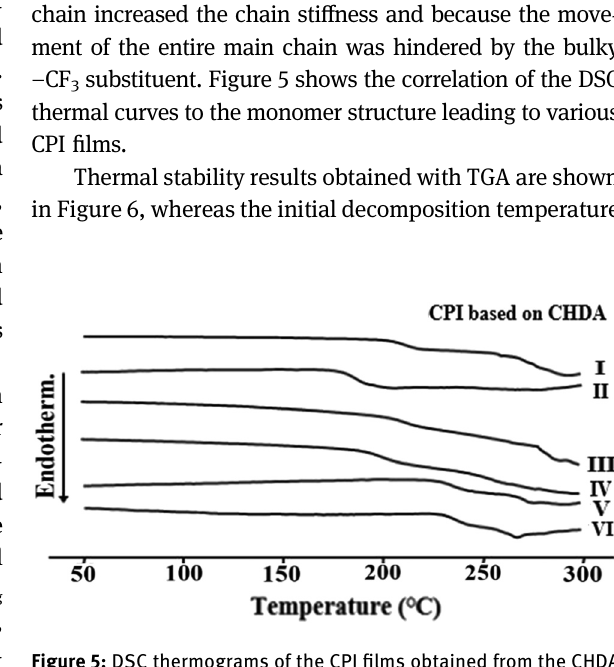
Figure 5: DSC thermograms of the CPI fi lms obtained from the CHDA